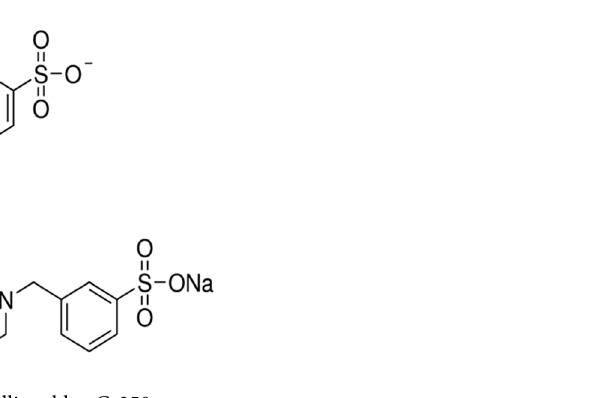
Scheme 1. Structure of coomassie brilliant blue